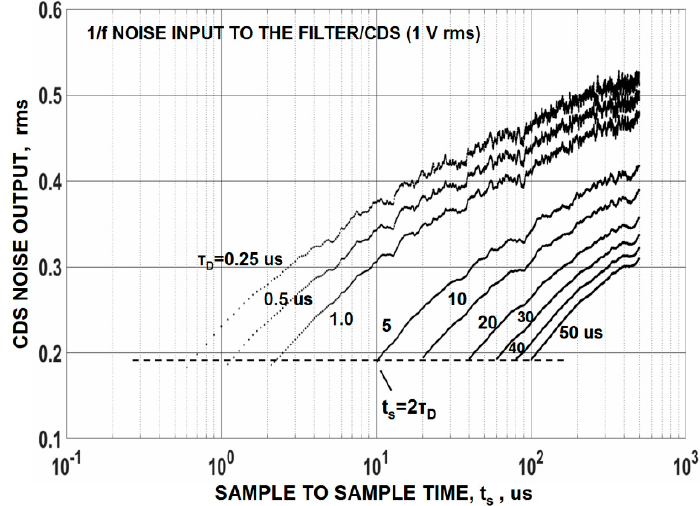
Figure 11. Computer simulated correlated double sampling (CDS) output noise in response of 1/ f noise [9]. The lack of correlation on 1/ f noise between samples is the cause for increase.